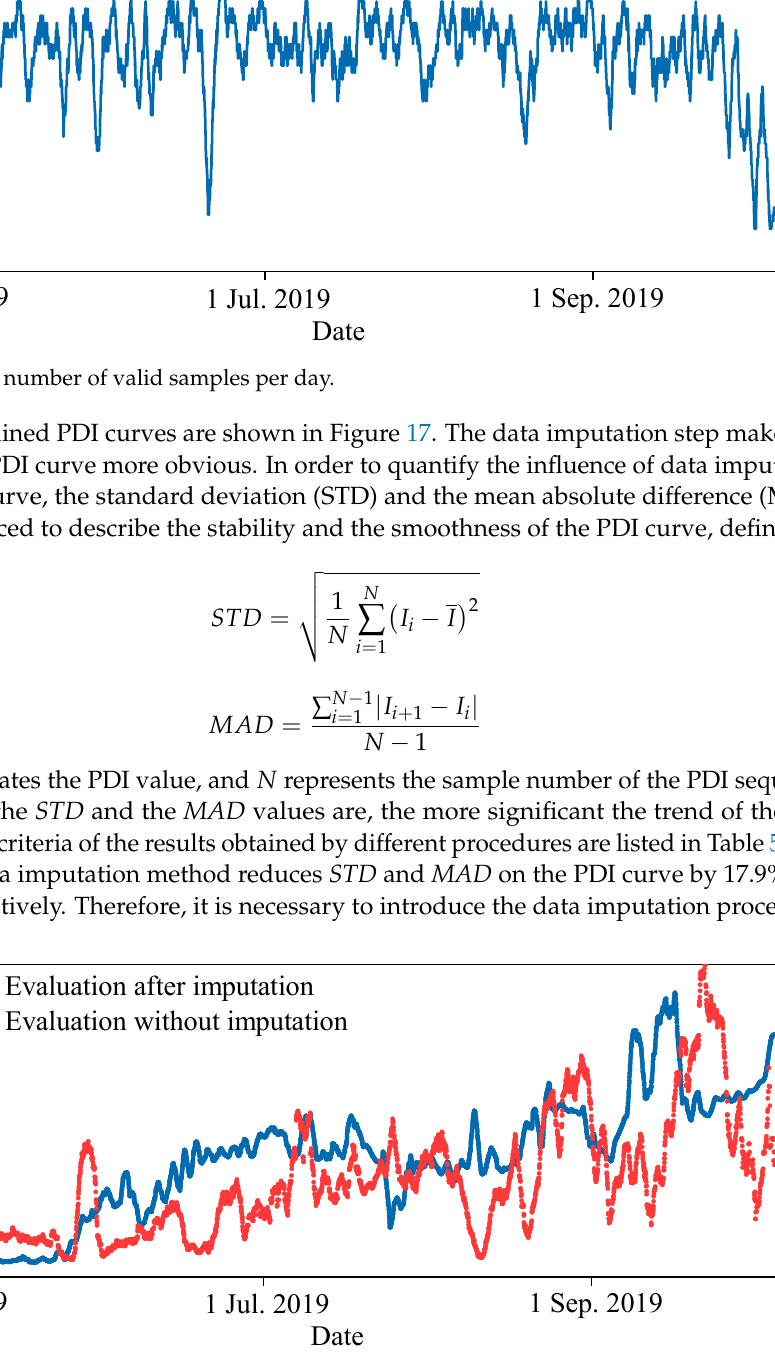
Figure 17. The influence of data imputation on PDI curve.